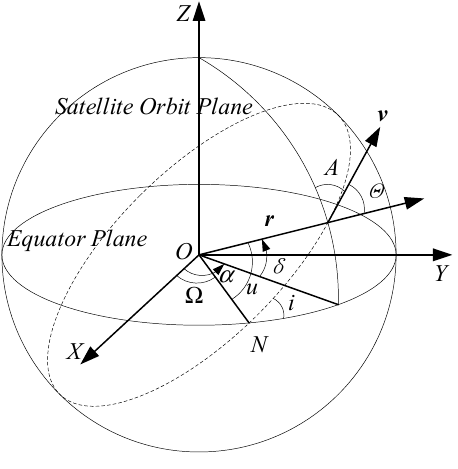
Figure 2. Satellite orbital parameters.